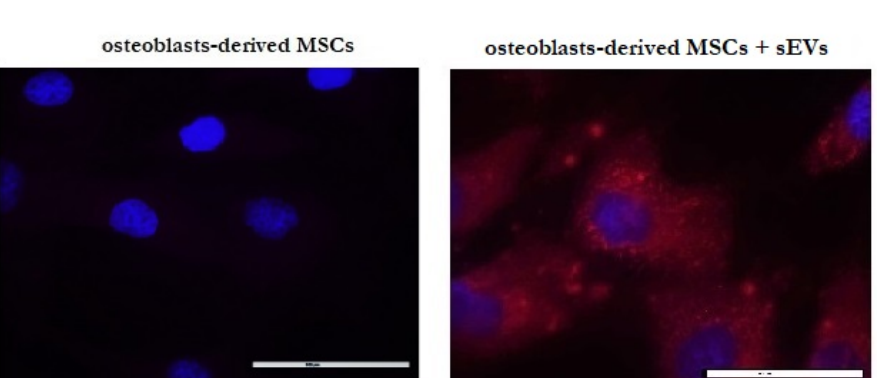
Figure 7. Fluorescence microscopy images demonstrated uptake of MSCs-CM-derived sEVs (labeled with ExoGlow MembraneT M labeling dye, red) by SF, Po-MSCs and osteoblasts (cell nuclei stained with DAPI, blue). Cells treated with PBS without sEVs were used as controls. Scale bar = 50 µm.